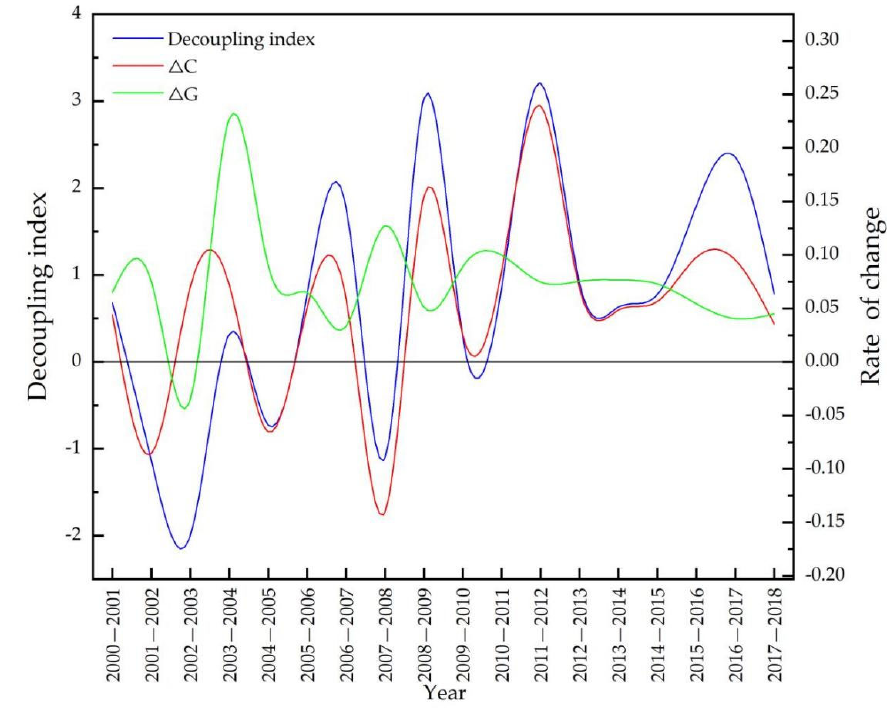
Figure 4. Decoupling index in Heilongjiang province during 2000–2018.